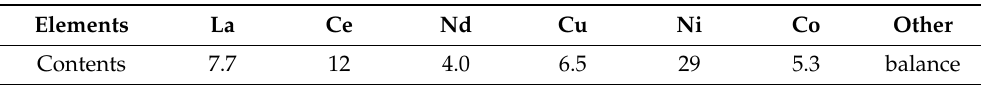
Figure 1. Pre-treatment of discarded electric vehicle batteries.